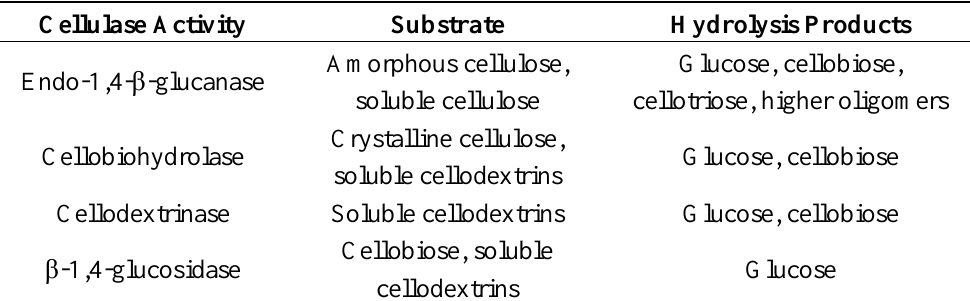
Table 1. Overview of the cellulase complex